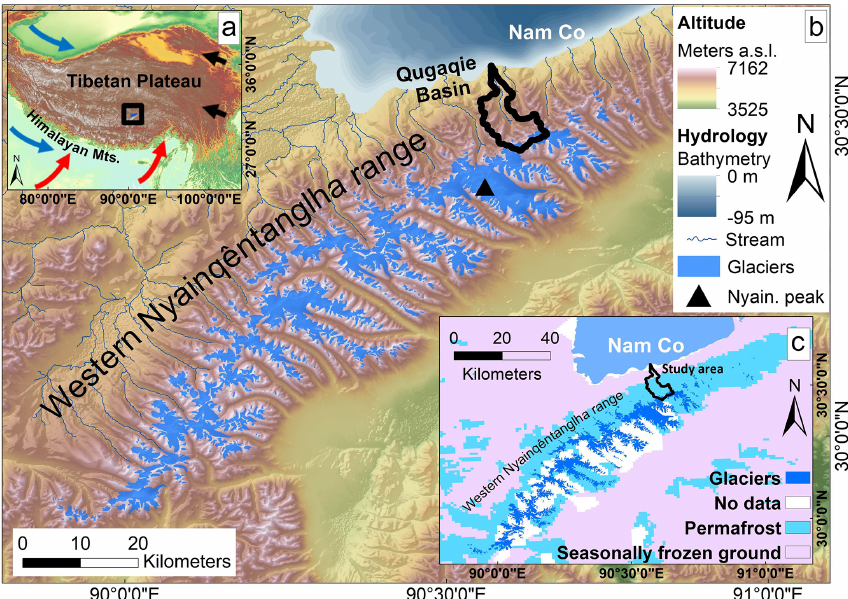
Figure 1. (a) Location of the study area within the Tibetan Plateau (TP) (background on SRTM DEM v4; Jarvis et al., 2008). Different wind systems influencing climate of the TP are shown by blue (westerlies), red (Indian summer monsoon) and black (East Asian monsoon) arrows based on Yao et al. (2012). (b) Overview map of the Nam Co catchment with the altitude colours and the study area of the Qugaqie catchment (thick black lines). Note the greater glacier extents on the south-oriented mountain range. Bathymetric data originated from Wang et al. (2009) (hillshade and DEM background based on SRTM DEM v4; Jarvis et al., 2008). Glacier extents originated from the GLIMS database (Cogley et al., 2015; Guo et al., 2015; Liu and Guo, 2014). (c) Permafrost distribution in the western Nyainqêntanglha range based on Zou et al.